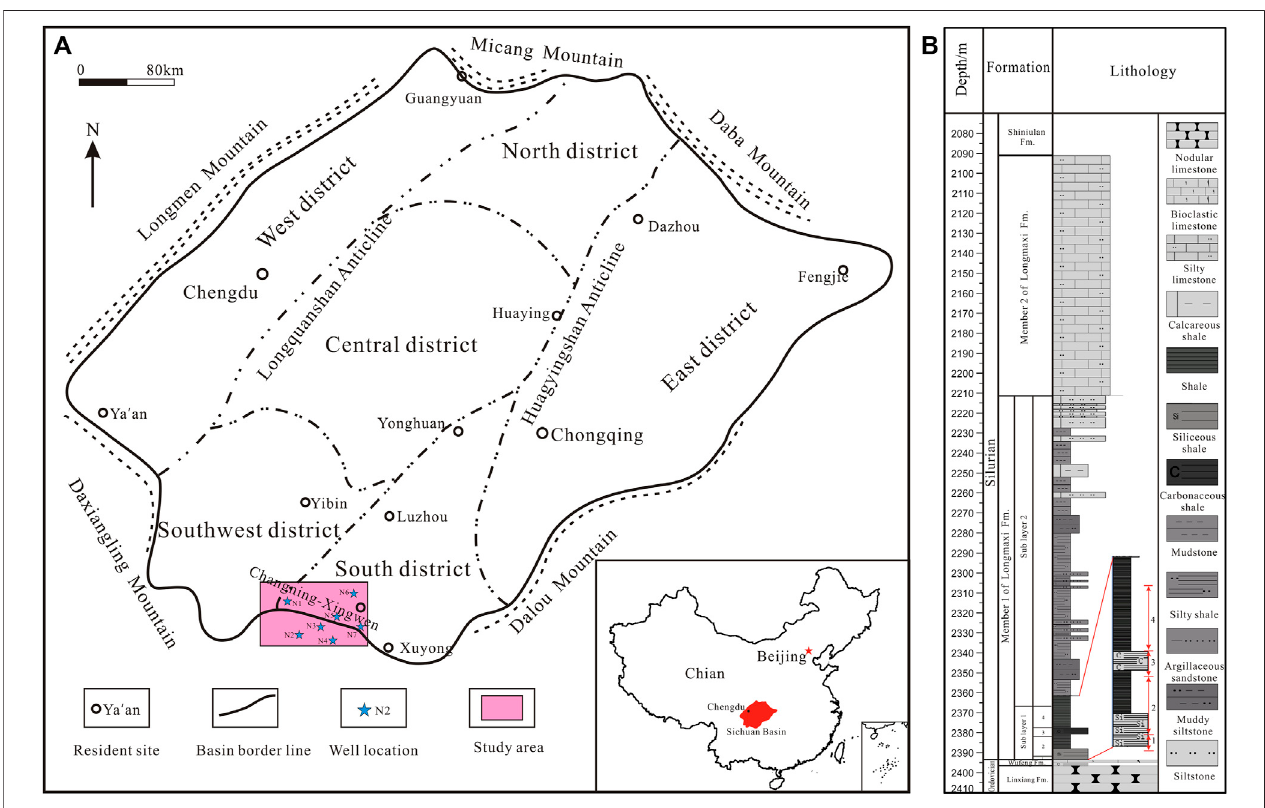
FIGURE 1 | (A) Location of the study area in the Sichuan Basin (Modi fi ed from Chen et al. (2014)); (B) stratigrapy of the Longmaxi Formation in well N3.